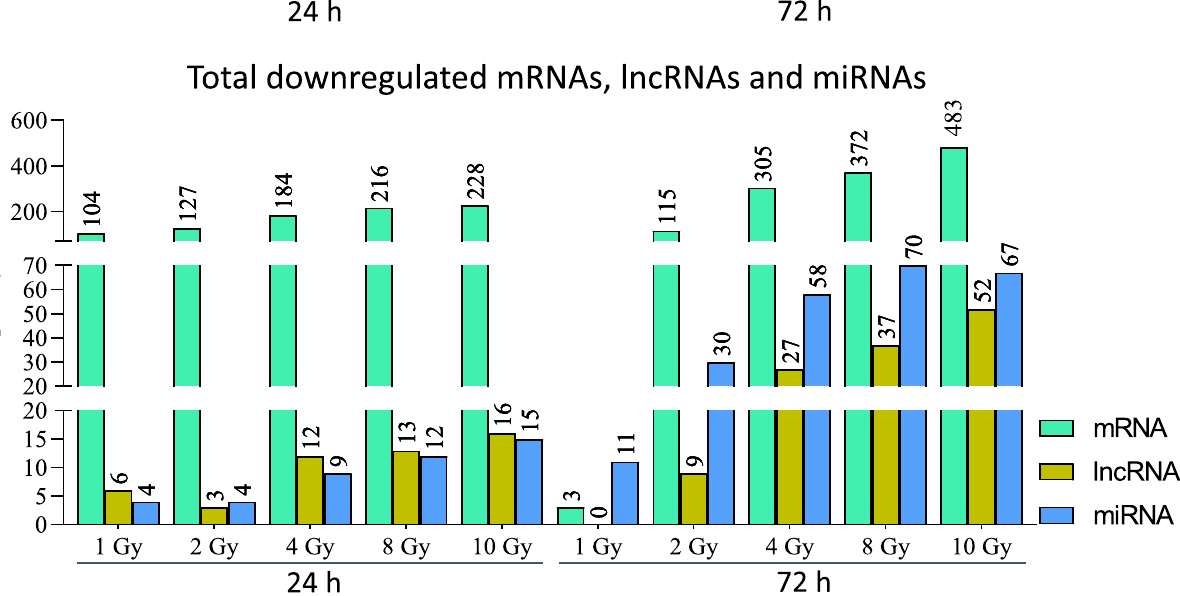
Figure 1. Summary of the sequencing data. ( A ) Total numbers of differentially upregulated mRNAs, lncRNAs and miRNAs for each dose and both 24 h and 72 h. ( B ) Total number of differentially downregulated mRNAs, lncRNAs and miRNAs for each dose and both 24 h and 72 h. ANOVA (FDR < 0.05) followed by Dunnett’s test (p-value < 0.05) was used to identify differentially expressed RNA molecules in each dose compared to control samples (fold change cut-off set at